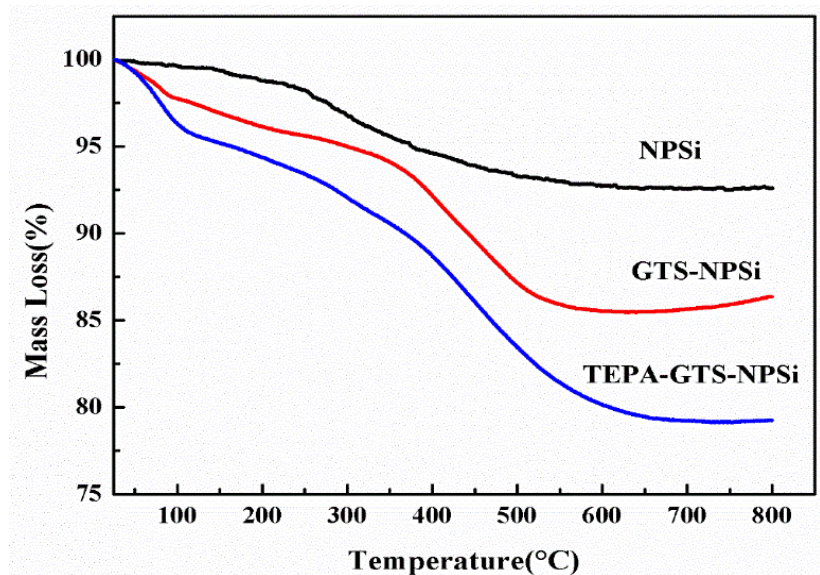
Figure 3. TGA analysis of NPSi GTS-NPSi and TEPA-GTS-NPSi.